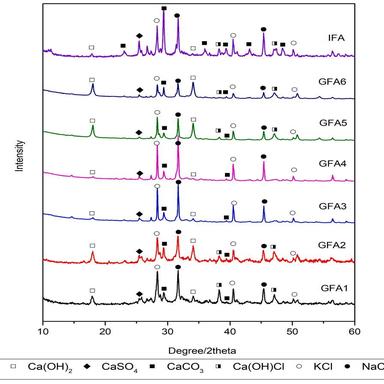
XRD patterns of GFAs and IFA.